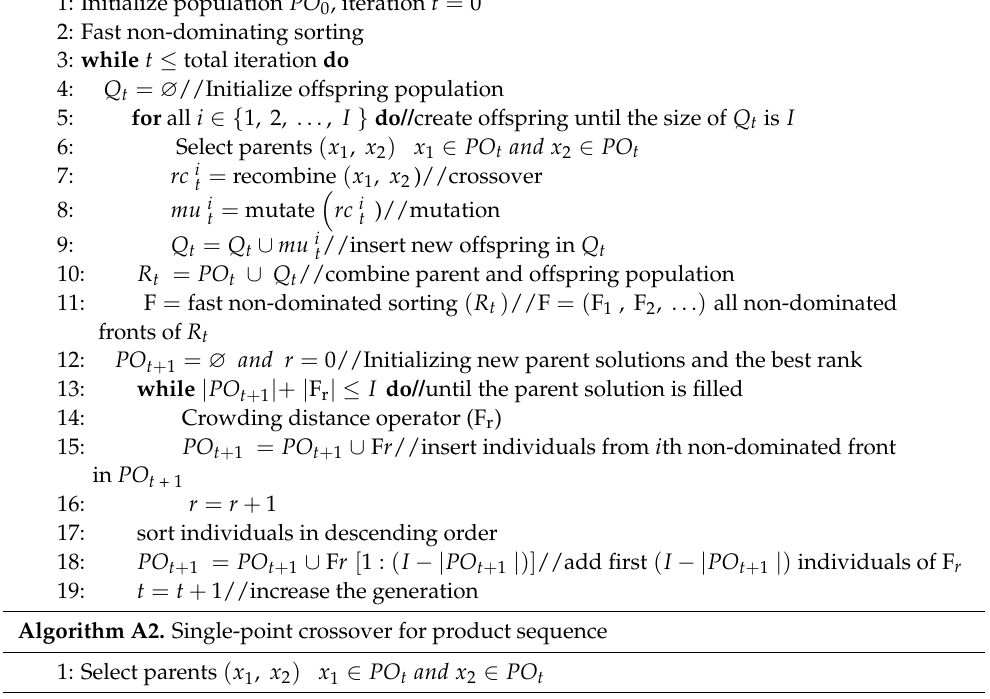
Algorithm A1. Non-dominated sorting genetic algorithm II (NSGA-II)